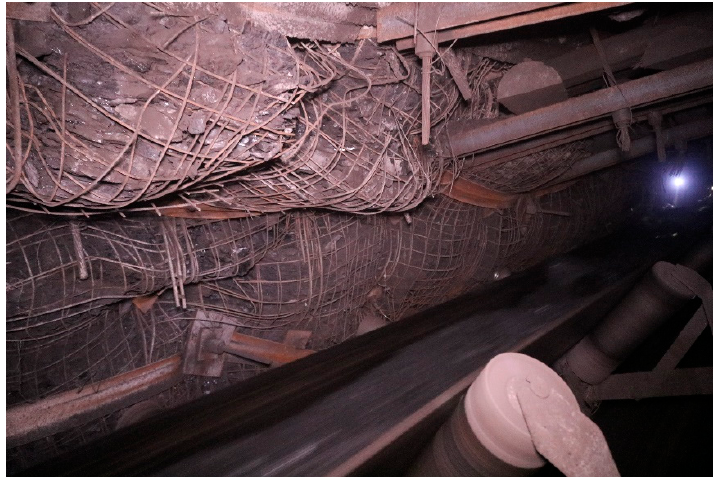
Figure 1. Deformation characteristics of the 121,302 machine roadway.